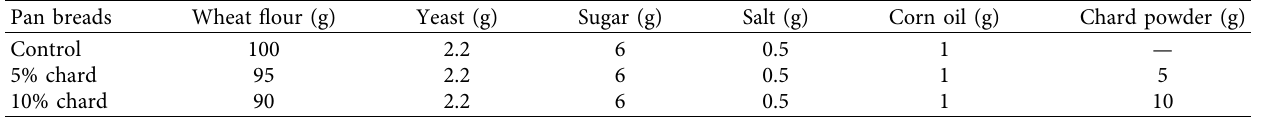
Table 1: Recipe of pan bread